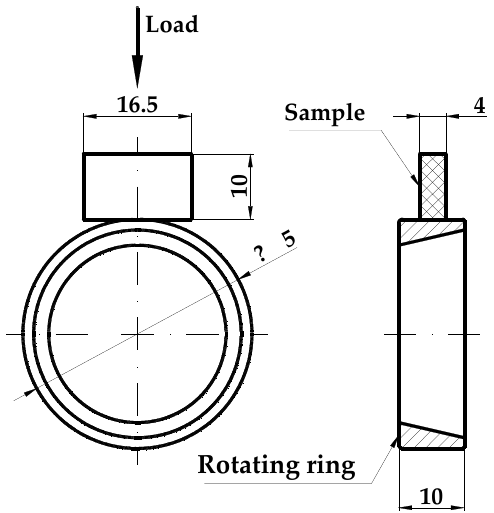
Figure 2. Dimensions (in mm) and shape of the tribotester elements. The materials code and the average values for mechanical characteristics of the poly- meric blends tested are presented in Table